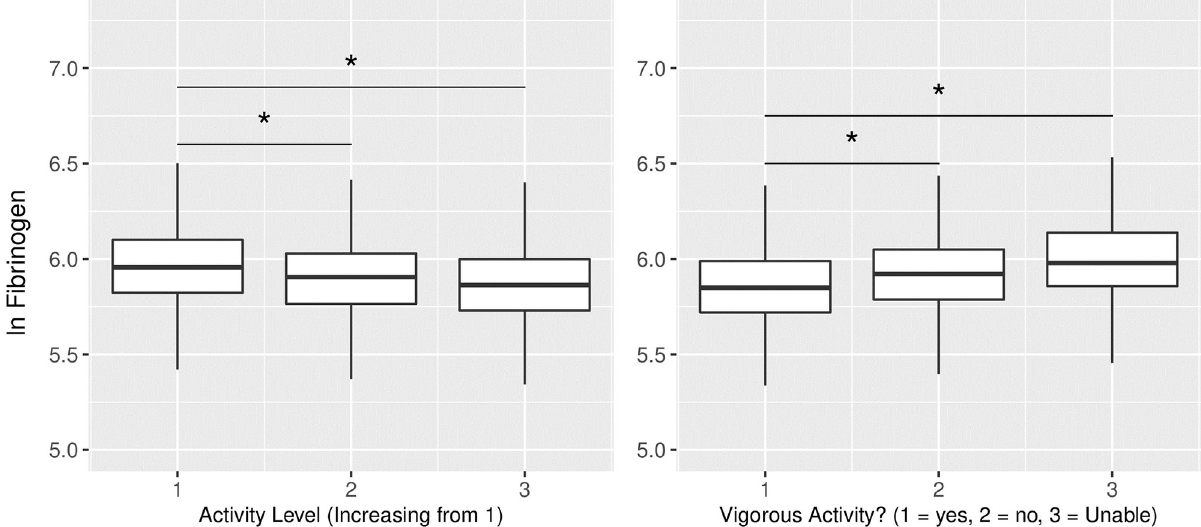
Fig 4. Higher physical activity relates to lower fibrinogen levels. Higher activity levels, as reported through the activity questionnaire (PAQ180 on left and PAD200 on right), were related to lower fibrinogen levels. � Denotes p <